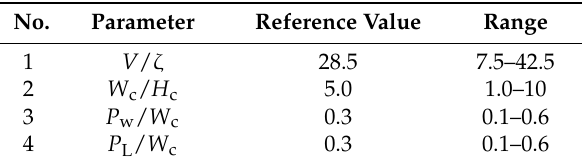
Table 1. Reference values and ranges of the